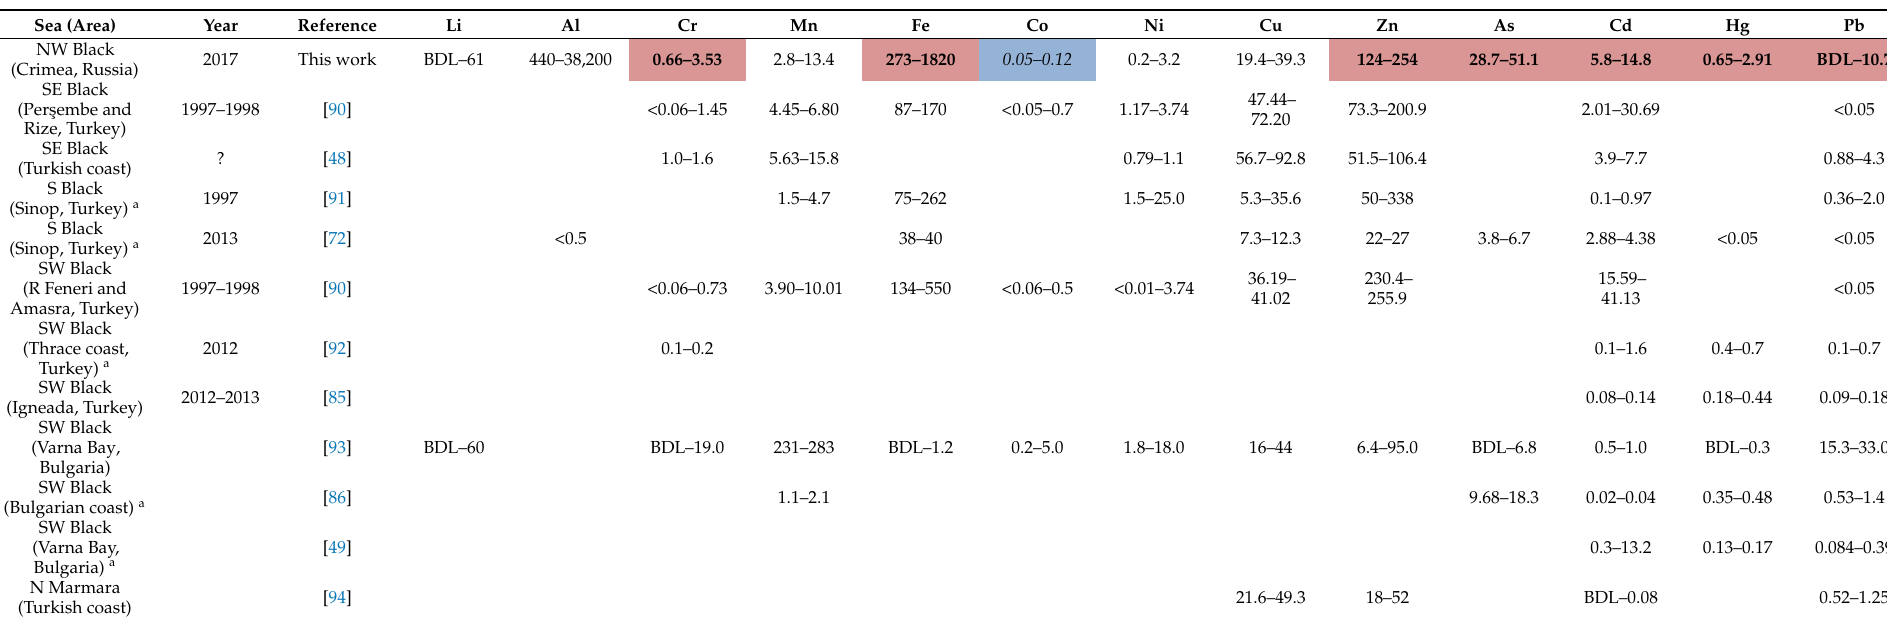
Table 6. Element contents (min–max) in soft tissues of the sea snail Rapana venosa collected in different areas of the Marmara and Black Seas. Notations, emphases and shadings mean the same as in Table